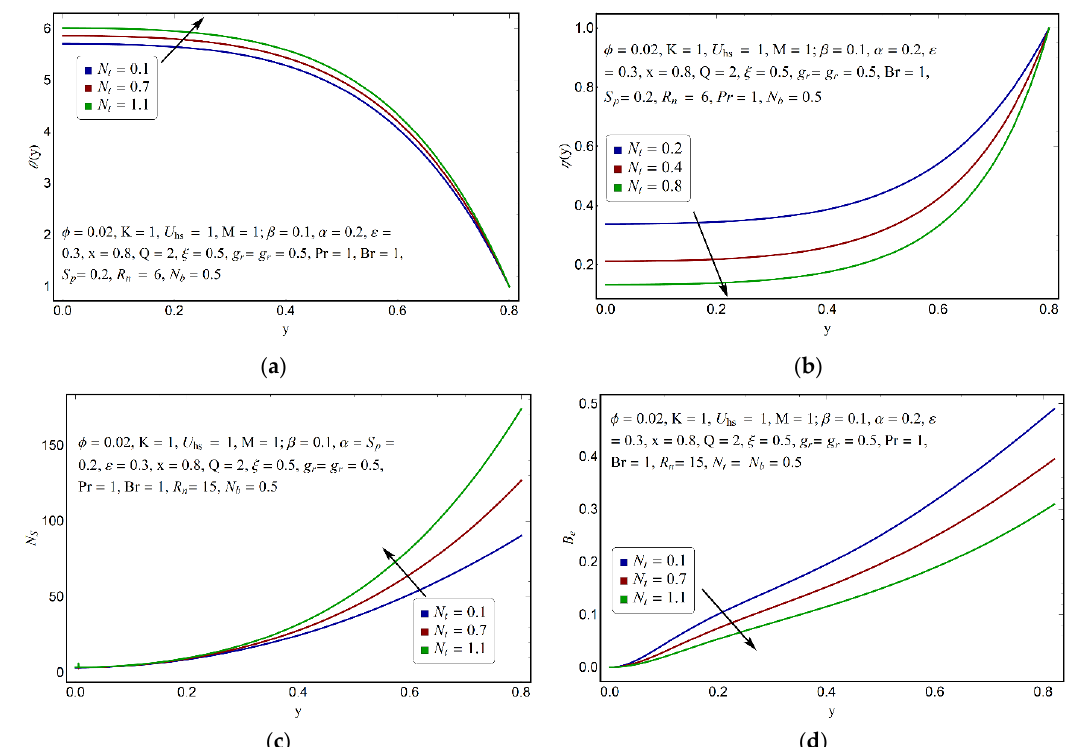
Figure 7. Impact of N t on ( a ) the temperature profile, ( b ) the mass concentration, ( c ) the entropy number, and ( d ) the Bejan number.